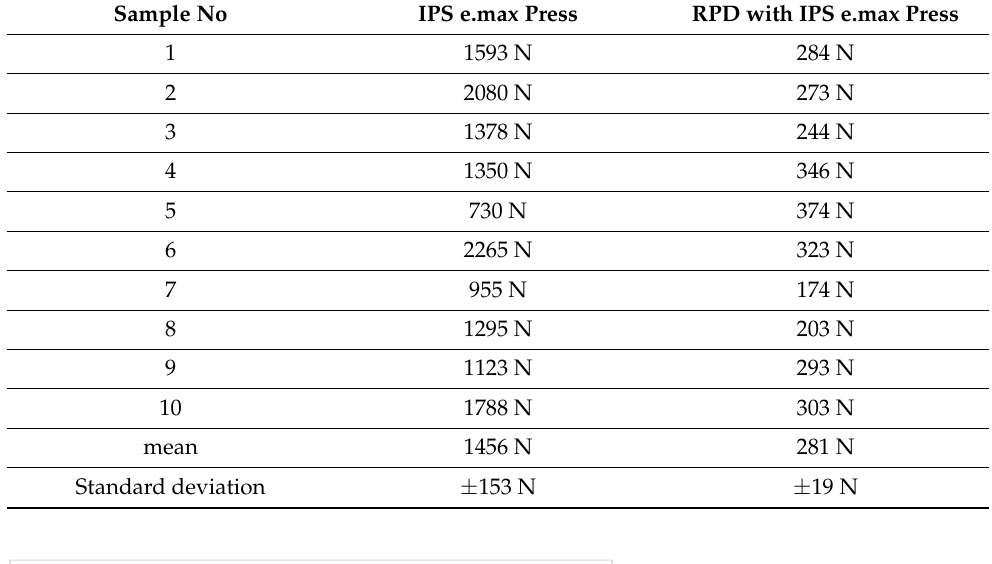
Figure 8. The mean fracture strength of zirconia crowns from the previous research [34] was signifi- cantly higher than that of RPD saddles with zirconia crowns in this study ( p ≤ 0.05). Table 4. The mean fracture strength of IPS e.max Press crowns from the previous research [32] was significantly higher than that of RPD saddles with IPS e.max Press crowns in this study ( p ≤ 0.05). Sample No IPS e.max Press RPD with IPS e.max Press